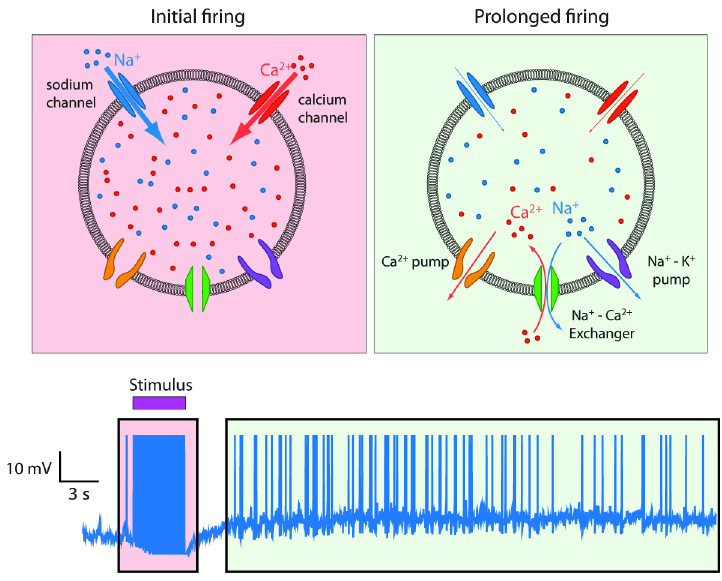
Fig 1. The ionic machinery behind prolonged firing. A schematic representation of a section in the dendritic tuft (top) showing the channels and transport mechanisms responsible for prolonged firing in AOB mitral cells (bottom). Image credit : Asaph Zylbertal